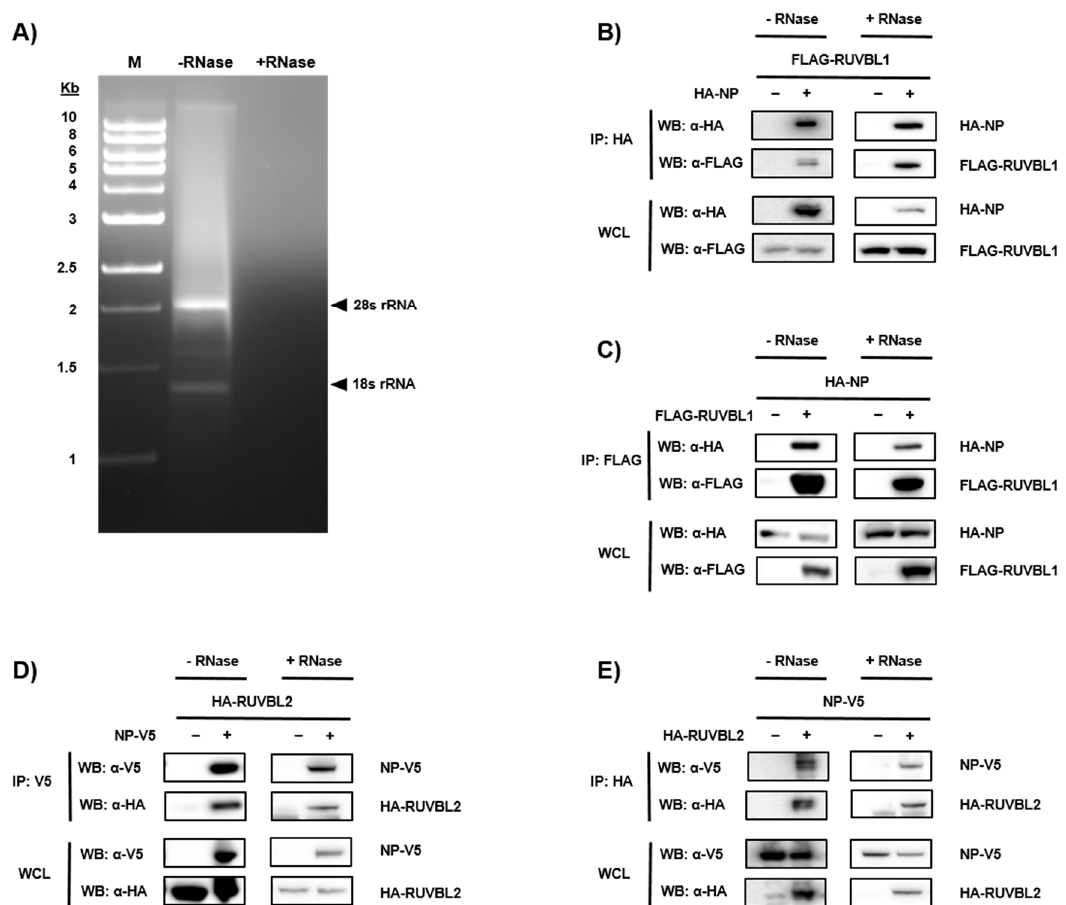
Figure 2. Validation of protein-protein interactions between EBOV NP and RUVBL1 and RUVBL2. ( A ) RNase treatment was confirmed using agarose gel electrophoresis on samples that were left untreated or treated with RNase (designated by − RNase or + RNase). ( B ) Confirmation of HA-NP and FLAG-RUVBL1 interaction in the absence or presence of RNase. Whole cell lysates (WCL) samples were run in parallel with immunoprecipitations (IP) samples to confirm appropriate protein expression. ( C ) Reciprocal validation of protein-protein interaction between HA-NP and FLAG-RUVBL1 by FLAG IP and − /+ RNase treatments. ( D ) Confirmation of NP-V5 and HA-RUVBL2 interaction by V5 IP and − /+ RNase treatments. ( E ) Reciprocal validation of protein-protein interaction between NP-V5 and HA-RUVBL2 by HA IP and − /+ RNase treatments. Monoclonal antibodies against HA, FLAG, and V5 were used to detect target proteins.